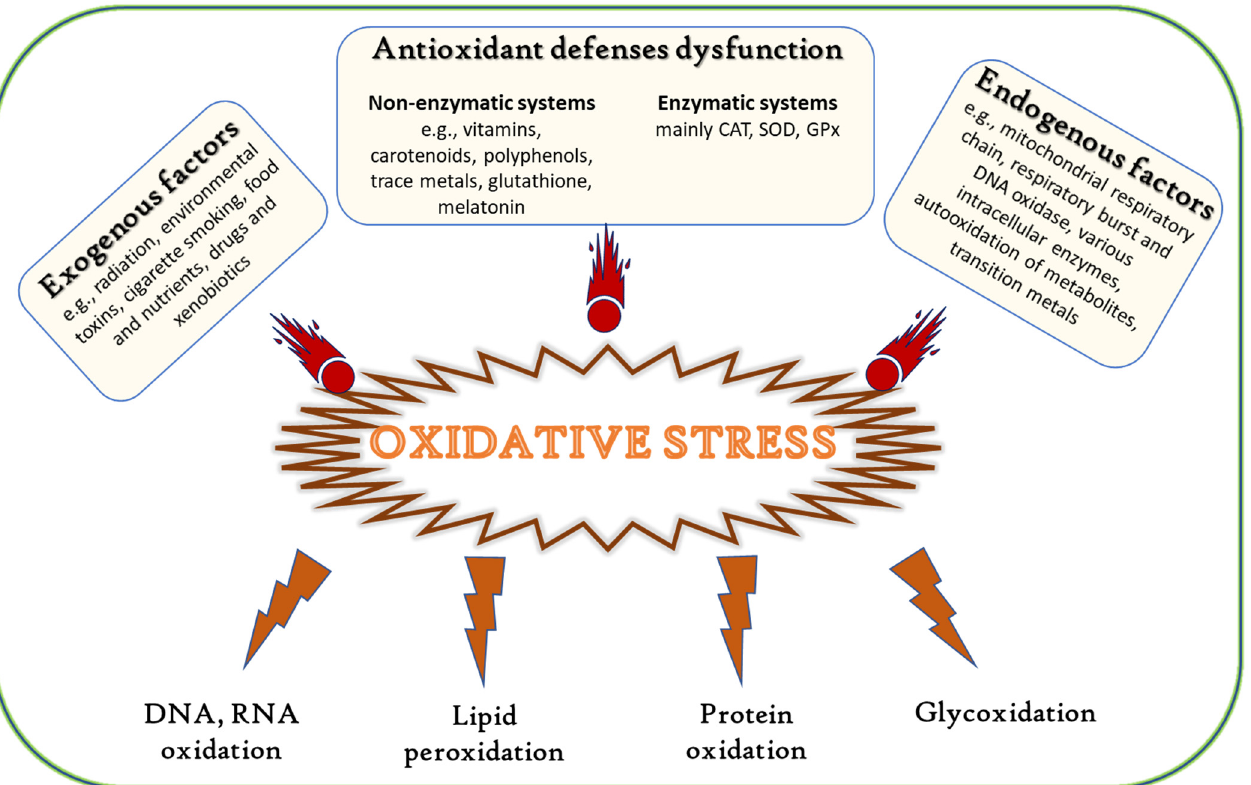
Figure 1. Causes and effects of oxidative stress (adapted from [6]).